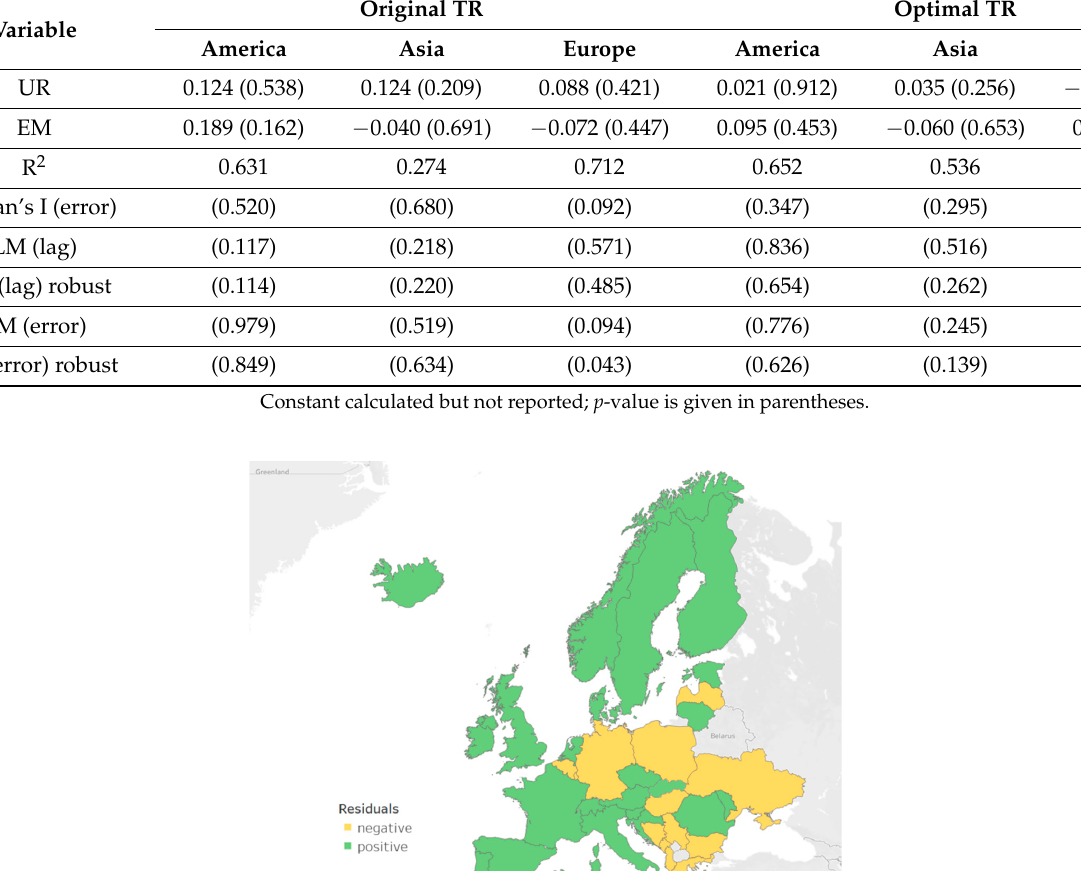
Table 5. Estimation results for ETI (new and optimised) for different continents. Table 7. Cont.